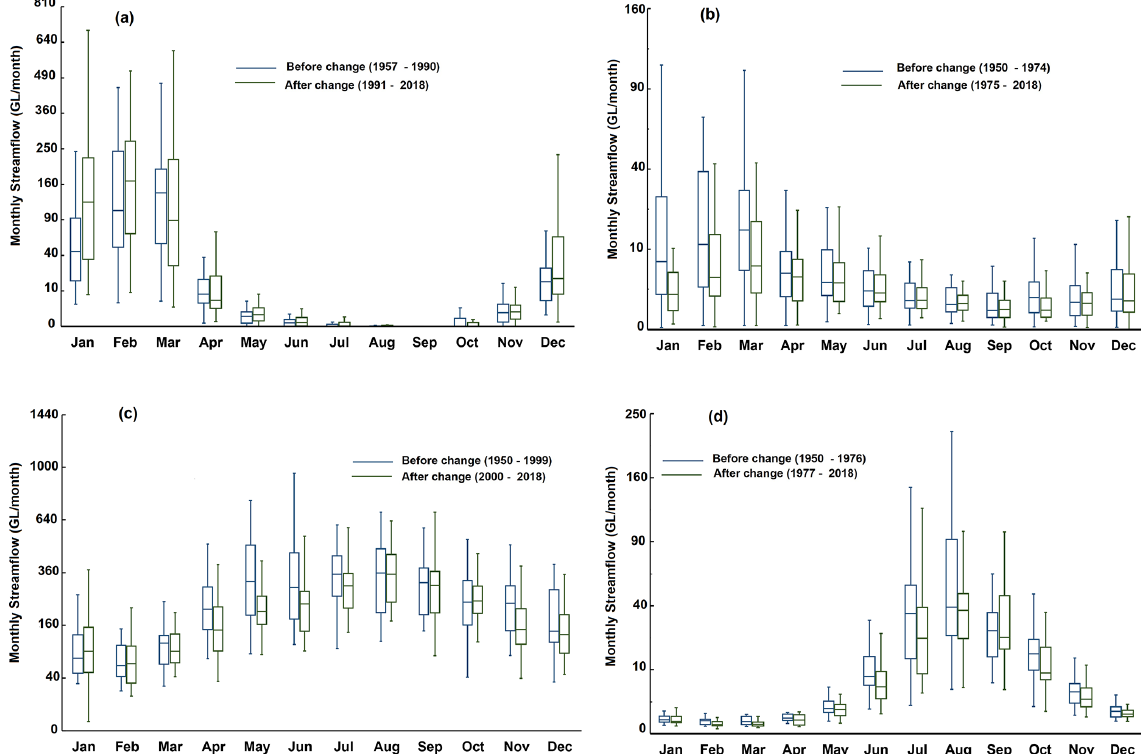
Figure 11. Distribution of mean monthly streamflow before and after step changes at four selected gauging stations representative of the (a) Tanami–Timor Sea Coast (VIII), (b) North East Coast (I), (c) Tasmania (III) and (d) South West Coast (VI) divisions; see Fig. 1 for